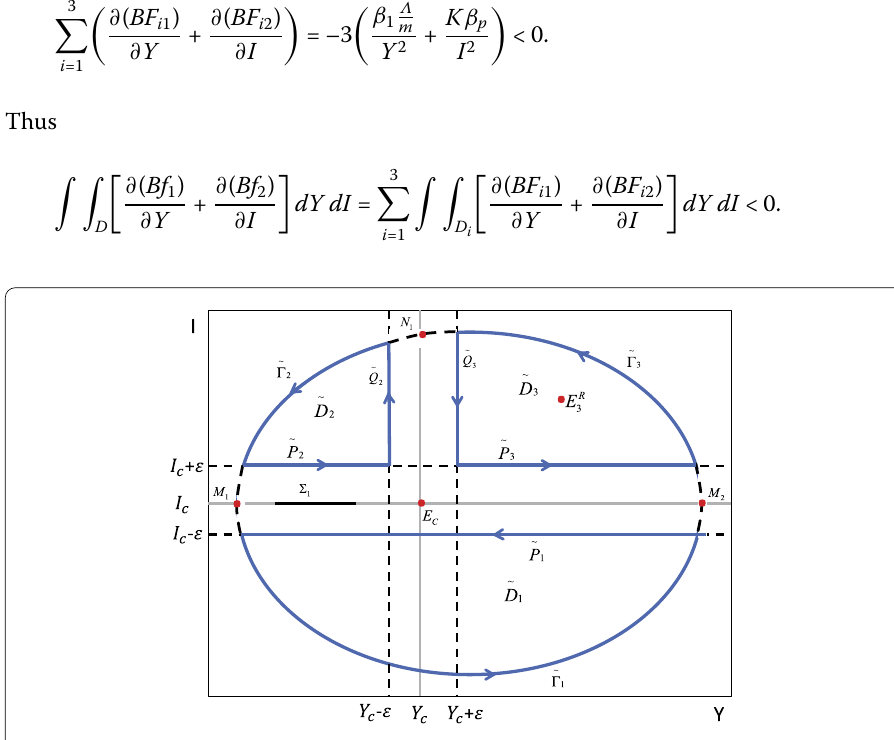
Figure 3 Schematic diagram illustrating the non-existence of a closed trajectory in system (1) with (2) in Case A.11 when E R 3 is a real